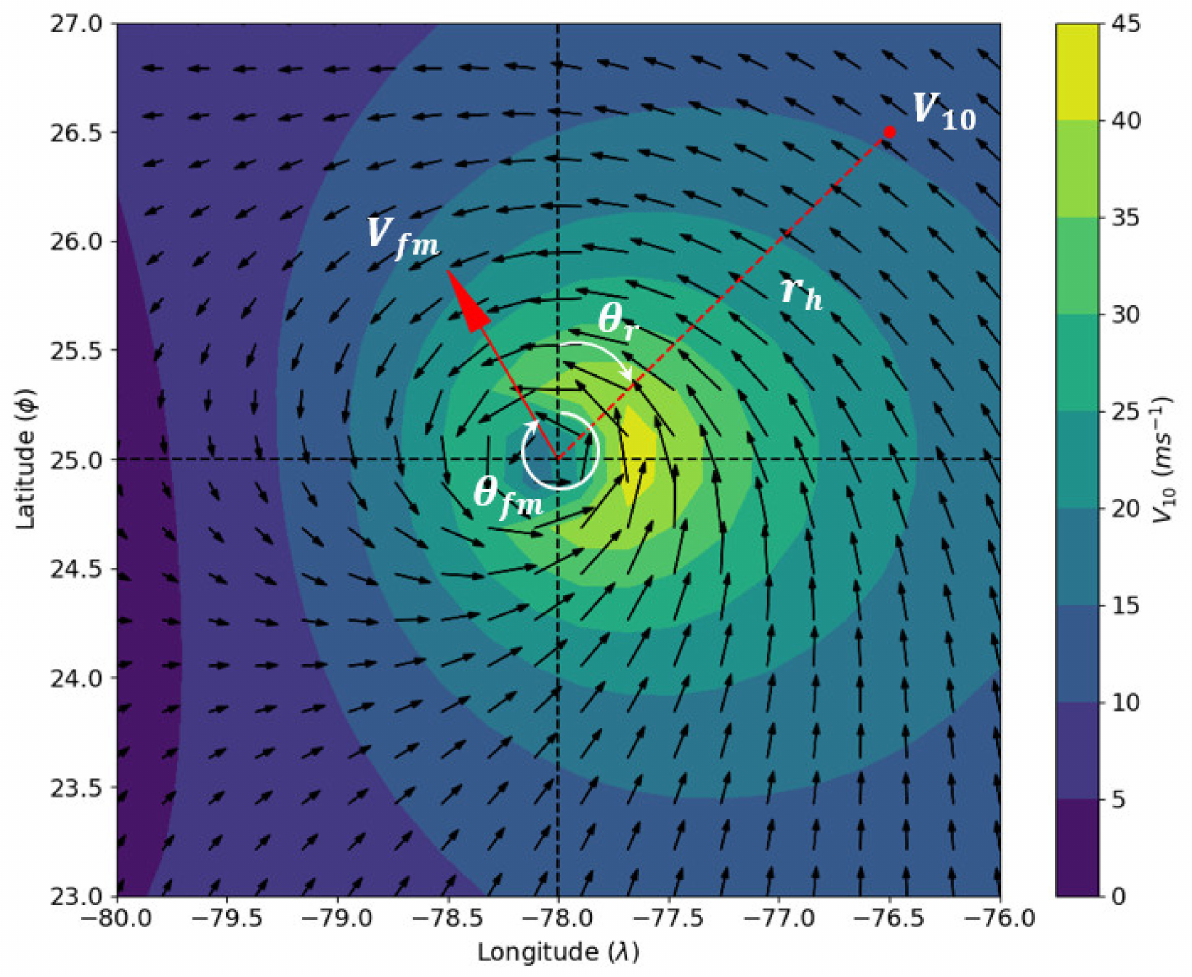
Figure 2. Wind field of a hypothetical hurricane in the Northern Hemisphere illustrating V fm , θ fm , and θ r relative to a point of interest located at distance r h from the